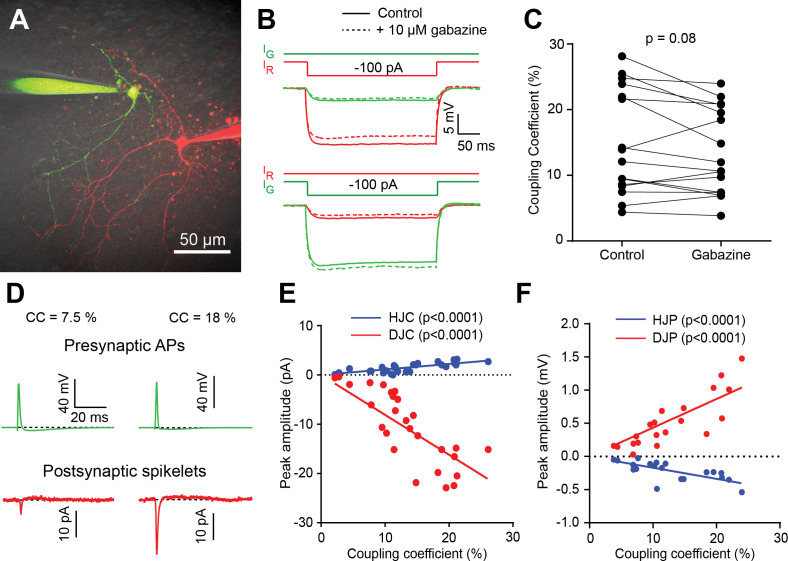
Electrical coupling strength between BCs correlates with spikelet amplitude.(A) 2PLSM image (maximal intensity projection) of two BCs loaded with 20 µM Alexa 594 (red), or 20 µm Alexa 488 (green) using dual whole-cell patch clamp. (B) Membrane potential of both cells (same color code as in A), when the red cell is injected with a hyperpolarizing current pulse (upper panel), or when the green cell is injected with the same current pulse (lower panel). Solid lines indicate responses in control conditions, while dashed lines correspond to responses recorded in 10 µM gabazine. Traces are averages of 50 sweeps. (C) Summary plot of unidirectional coupling coefficients (CCs), showing that they are not significantly altered by gabazine addition (n = 16 cells from 8 BC pairs, Wilcoxon matched-pairs signed rank test, p=0.08). (D) Two representative paired BC recordings, one with an average (left) and one with a high bidirectional CC (right), and their corresponding spikelet currents (red traces, holding membrane potential of −70 mV) resulting from an AP elicited in the presynaptic cells (green traces, RMP of −70 mV). (E) Summary plot of paired recordings showing the relationship between spikelet inward currents (depolarizing junction current, DJC, red), fAHP-mediated outward current (hyperpolarizing junction current, HJC, blue) and CC (n = 20 spikelet recordings). Note that in these recordings, presynaptic (transmitting) cells were maintained at approximately −70 mV, and 10 µM gabazine was present to block GABAergic inputs. Lines are linear regressions (n = 27 cells from 14 pairs; HJC: p<0.0001, DJC: p<0.0001) (F) Similar to B, but for spikelets recorded in current clamp (n = 27) DJP: depolarizing junction potential; HJP: hyperpolarizing junction potential. Lines are linear regressions (n = 20 cells from 10 pairs; HJP: p<0.0001, DJP: p<0.0001). Holding potentials were ~−70 mV. See also Figure 4—source data 1.